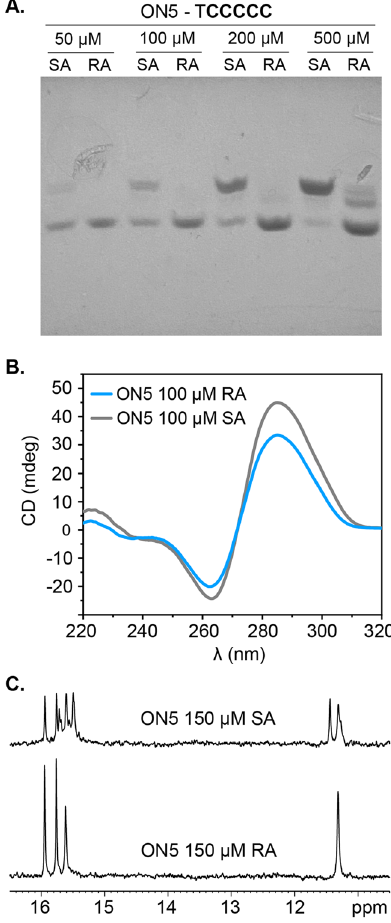
Fig. 2 In fl uence of oligonucleotide concentration and annealing method on ON5 structural populations. A Non-denaturing gel electrophoresis of ON5 across different concentrations upon RA and SA. B CD spectra of 100 μ M RA (blue) and SA (gray) ON5 at 5 °C. C 1 H NMR imino signals of 150 μ M RA ON5 and SA ON5 at 5 °C. Buffer conditions are aqueous 10 mM NaP i pH 5 (10% D 2 O for NMR